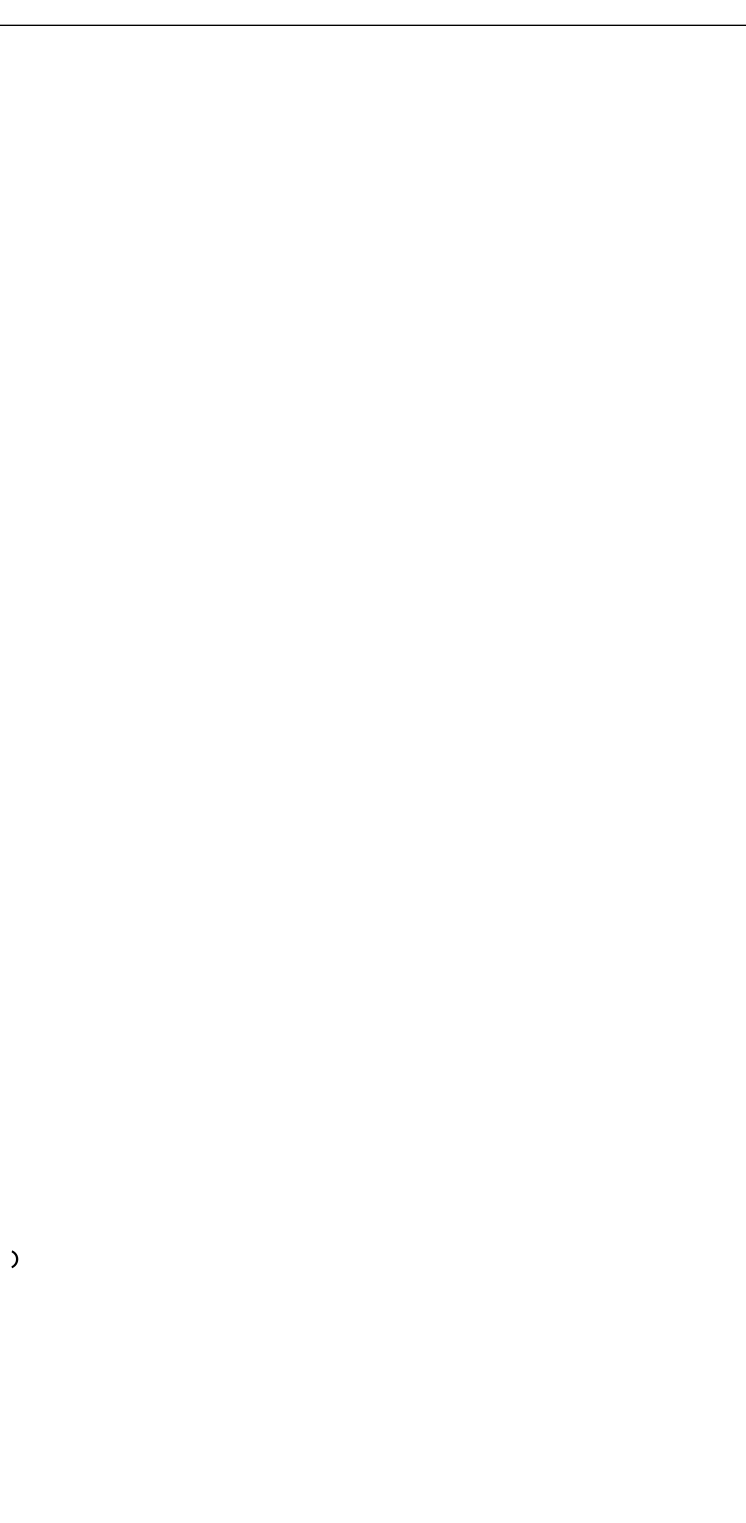
Table 1. Baseline characteristics of the study sample